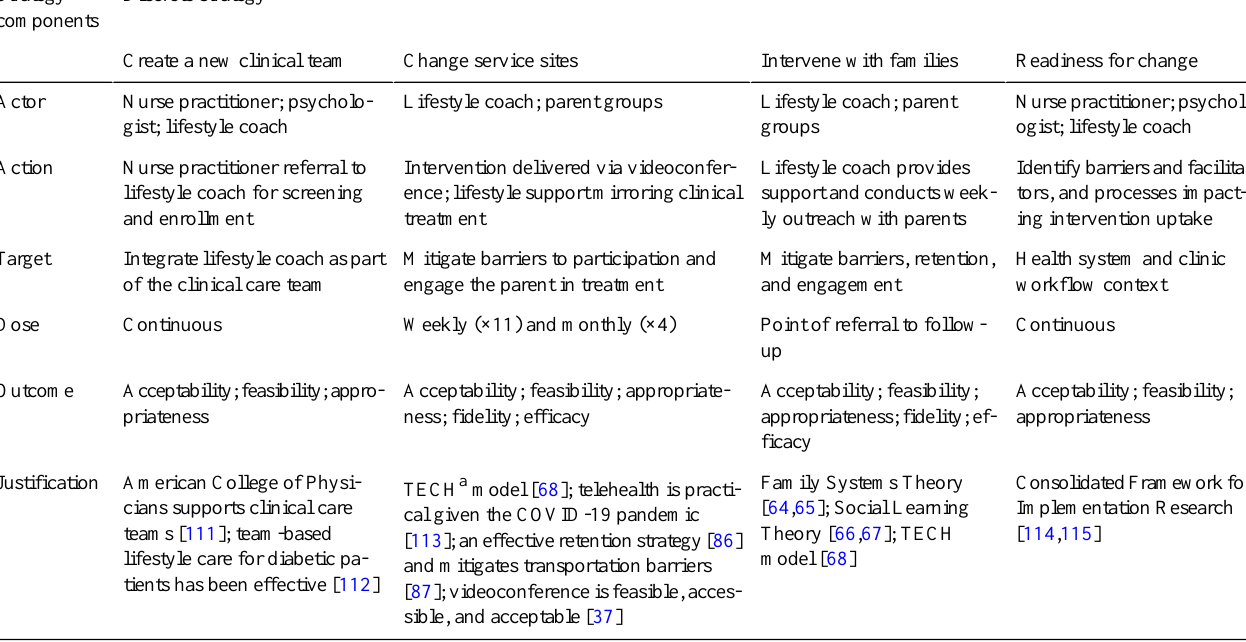
Table 2. Operationalization of discrete implementation